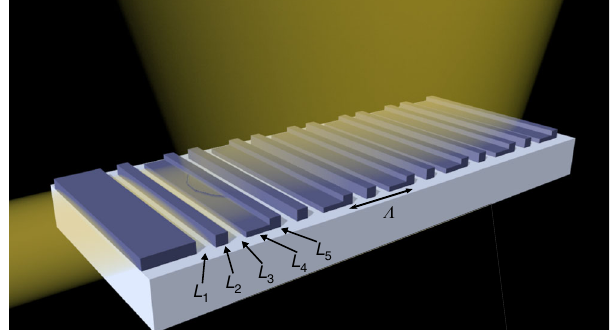
Fig. 2 Schematic representation of the grating coupler structure. The guided light incident from the left is diffracted vertically by a grating periodically interleaving a pillar of height 220 nm and an L-shaped section partially etched to 110 nm. The L-shape approximates the angled facet of a conventional blazed grating 21 in a way that can be fabricated with standard lithography and etch methods. The pillars are designed to suppress back re fl ections by destructive interference. The fi ve design parameters L 1 – L 5 de fi ne the original fi ve-dimensional parameter space and the grating period Λ this work. As a primary optimization objective, we choose the coupling ef fi ciency η of the diffracted TE-polarized light to a standard single-mode optical fi ber (SMF-28) placed vertically on top of the grating. Low back re fl ection r is another important criterion in minimizing the impact of the grating to other upstream components in the system 30,31 . These considerations lead to the formulation of the optimization problem for the fi rst stage represented in Fig. 1a as: